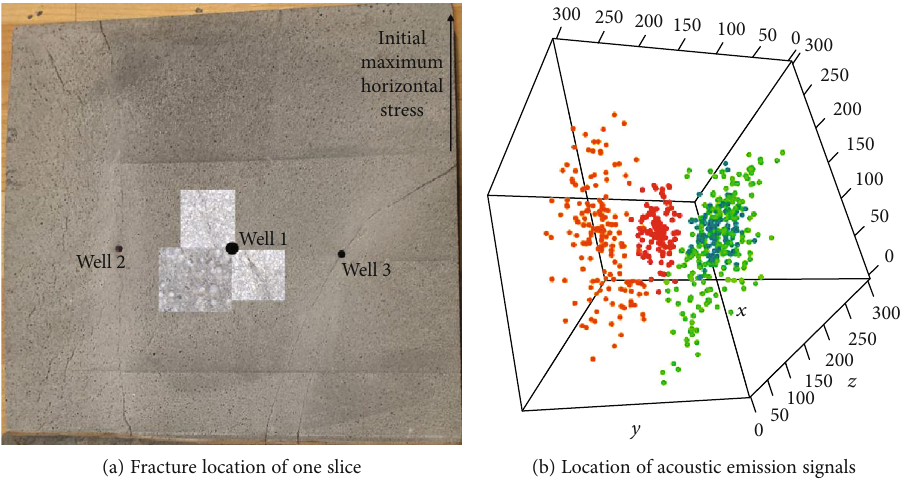
Figure 6: Diagram of fracture propagation in one slice ( 30cm × 30cm ) and 3D scatter diagram of acoustic emission location of sample 2 ( 30 cm × 30cm × 30 cm ) stereoscope images of tiny fractures around well 1 in the sliced sample under digital microcamera.